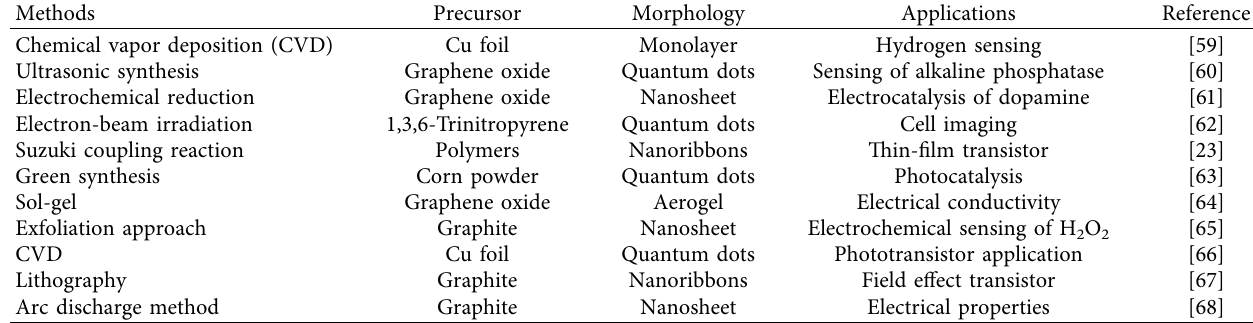
Table 1: Diverse approaches for the synthesis of graphene with their applications.